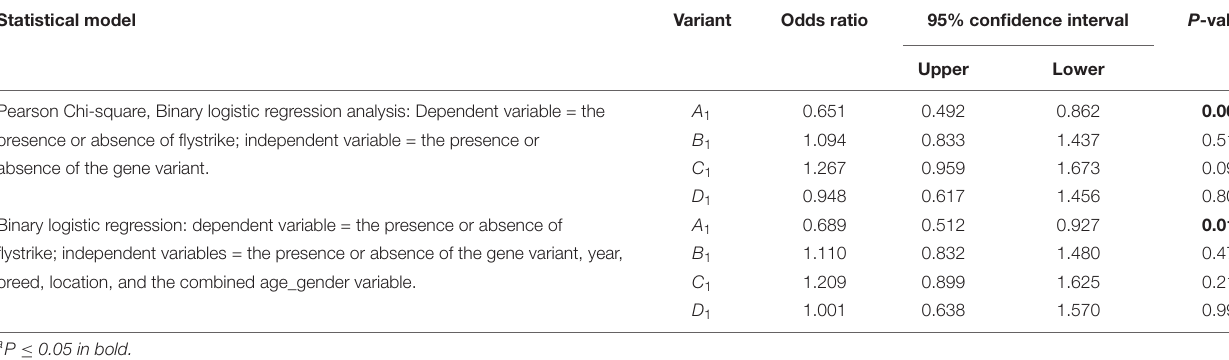
TABLE 3 | The association of the presence of each FABP4 Region-1 variant with the occurrence of flystrike given the presence of a particular FABP4 Region-1 variant. Statistical model